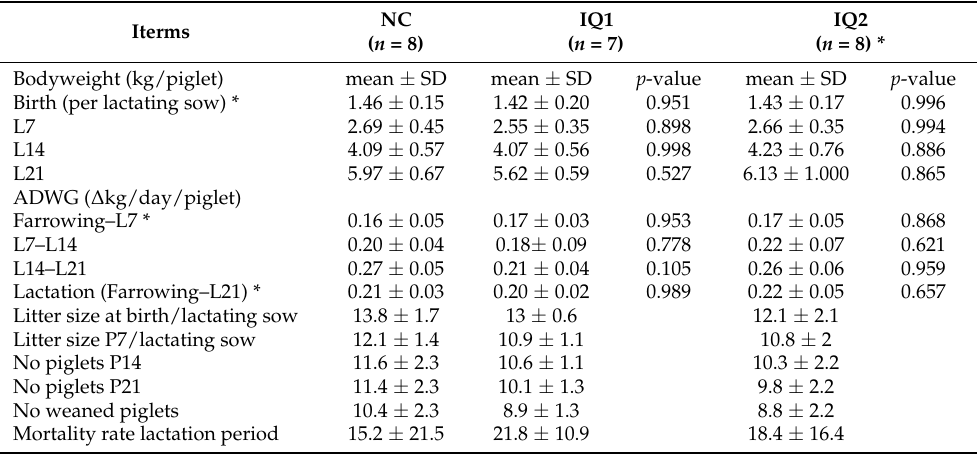
Table 6. Performance of piglets born from sows that received either a basal diet (NC) or supplemen- tation with isoquinoline alkaloids (IQ) during gestation (90 ppm) and lactation (150 ppm) (IQ1), or only during the lactation period (IQ2): body weight at birth (kg), on postnatal day 7 (L7), 14 (L14) and 21 (L21, weaning); average daily weight gain (ADWG) at one-week intervals and in the lactation period overall.